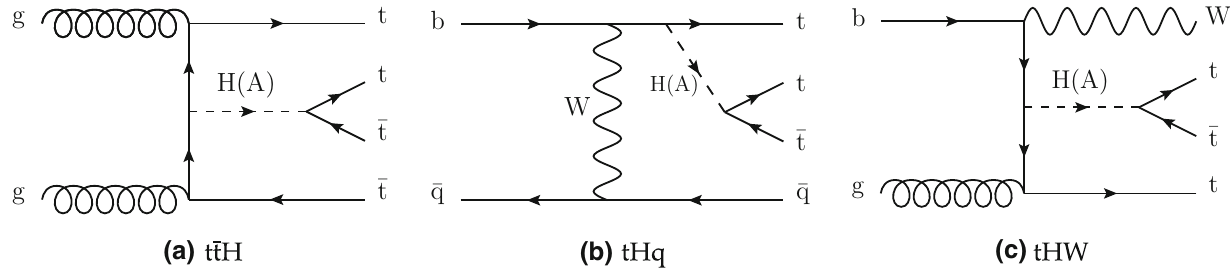
Fig. 2 Diagrams for scalar (pseudoscalar) boson production in association with top quarks + the gluino, (cid:2) g → tt (cid:2) χ 0 (T1tttt) and (cid:2) g → tb (cid:2) χ (T5ttbbWW), 1 1 resulting in events with four W bosons and four b quarks.